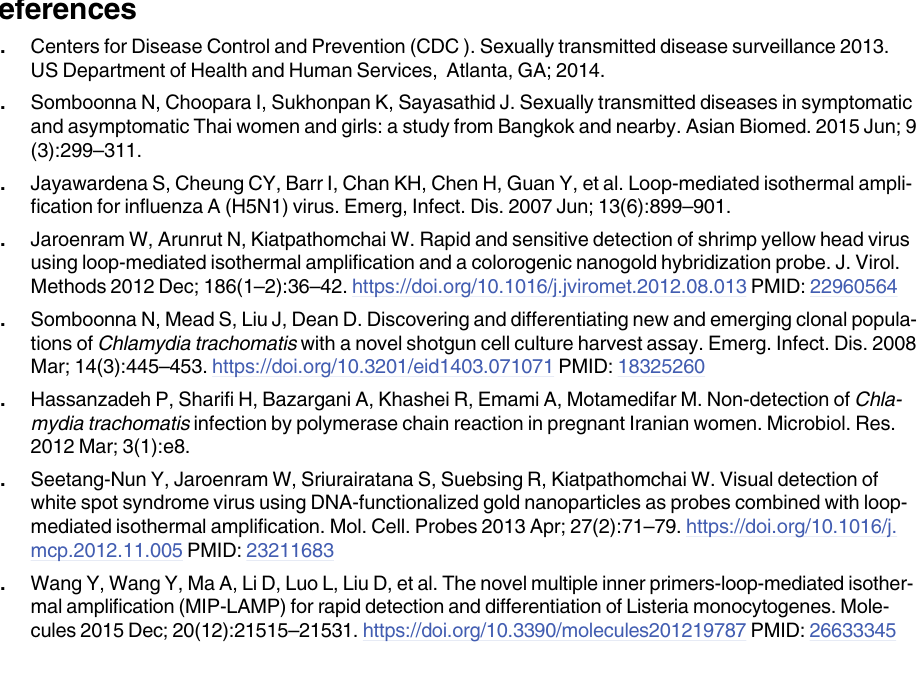
S2 Fig. Optimized ratios of LAMP-to-AuNP volume for optimal color contrast between positive and negative test results. Positive, red; Negative, purple/blue/gray. AuNP, gold nano- particle probe; LAMP, loop-mediated isothermal amplification. (TIF) S3 Fig. Specificity determination of LAMP-GE against fungal Candida albicans . The first lane is GeneRuler 100 bp plus DNA ladder, followed by a no template control, and C . albicans lanes, respectively. GE, gel-electrophoresis; LAMP, loop-mediated isothermal amplification. (TIF) S4 Fig. LOD of C . trachomatis omp A at 11.25 and 22.5 genome equivalent copies (0.010625 fg and 0.02125 fg), lanes 1 and 2, respectively, by LAMP-GE. M represents 100 bp DNA Lad- der RTU (GeneDireX, Inc., Miaoli County, Taiwan). The LAMP reaction was as described in the legend of Fig 1, with incubation at 61˚C for 35 minutes. GE, gel-electrophoresis; LAMP, loop-mediated isothermal amplification; ompA , outer membrane protein A. (TIF) S1 Table. Clinical sample evaluation of crude DNA lysis combined LAMP-GE and LAM- P-AuNP, compared with a commercial DNA extraction kit and PCR-GE, for the indepen- dently replicated assays. For specificity, the values in parentheses represent the number of true negatives divided by the number of true negatives and false positives. For sensitivity, the values in parentheses represent the number of true positives divided by the number of true positives and false negatives. AuNP, gold nanoparticle probe; GE, gel-electrophoresis; LAMP, loop-mediated isothermal amplification; PCR, polymerase chain reaction.